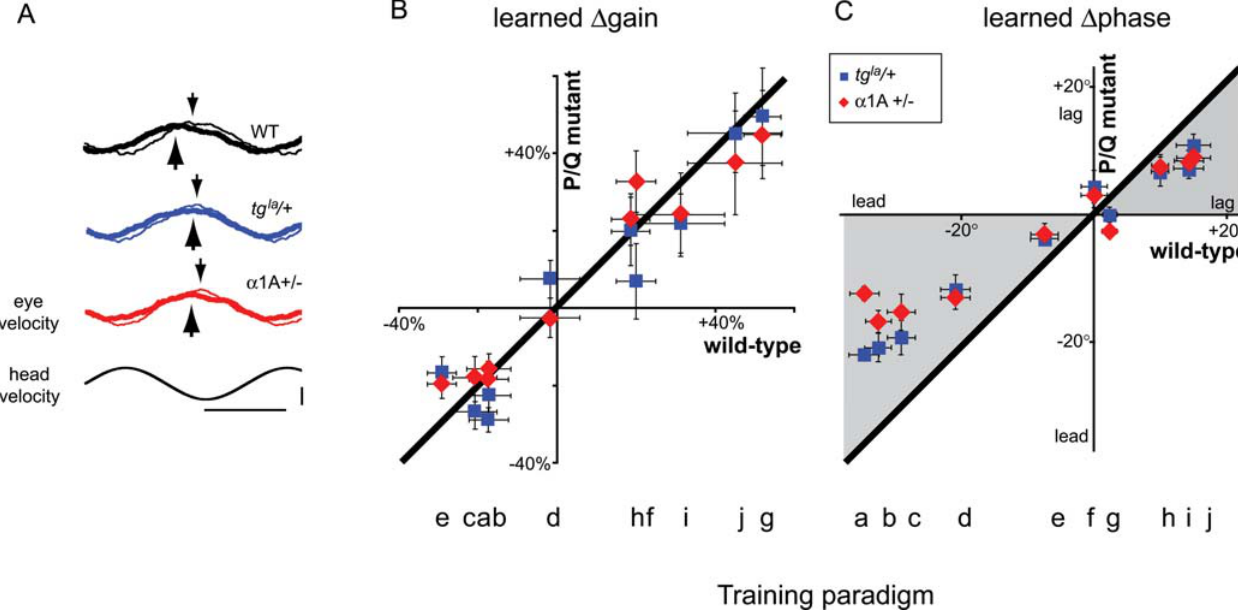
heterozygous mouse ( tg la / + : blue) and an a 1A hemizygous mouse ( a 1A + / 2 : red). Horizontal calibration bar indicates 500 ms; vertical bar indicates 10 u /s for head velocity, 5 u /s for eye velocity. Average changes in B) VOR gain and C) VOR phase induced by each visual-vestibular training paradigm in the wild-type mice (abscissa) and the P/Q mutants (ordinate). The training paradigm is indicated by the letter below each set of corresponding data points (a–j, see Table 1). Error bars indicate standard error. See Table 1 for number of animals in each group.